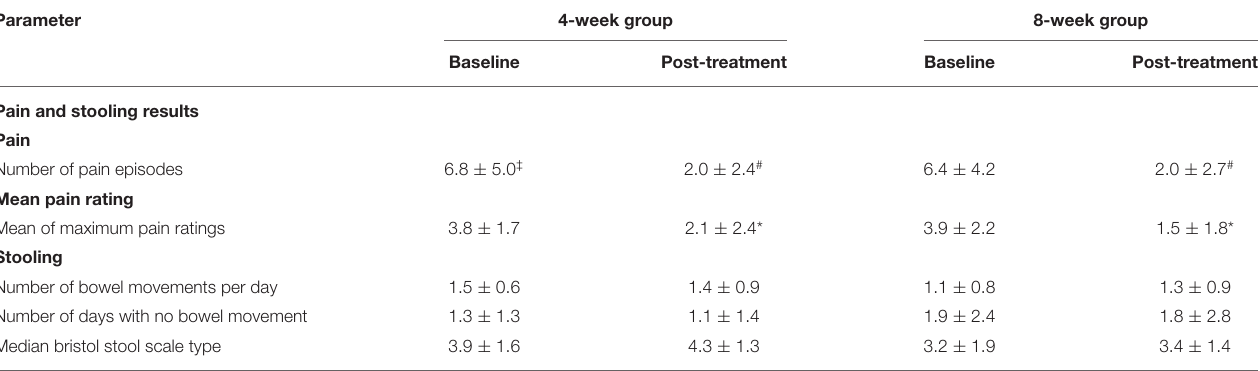
‡ Mean ± SD. * P = 0.049 for post-treatment change within each group. # P = 0.034 for post-treatment change within each